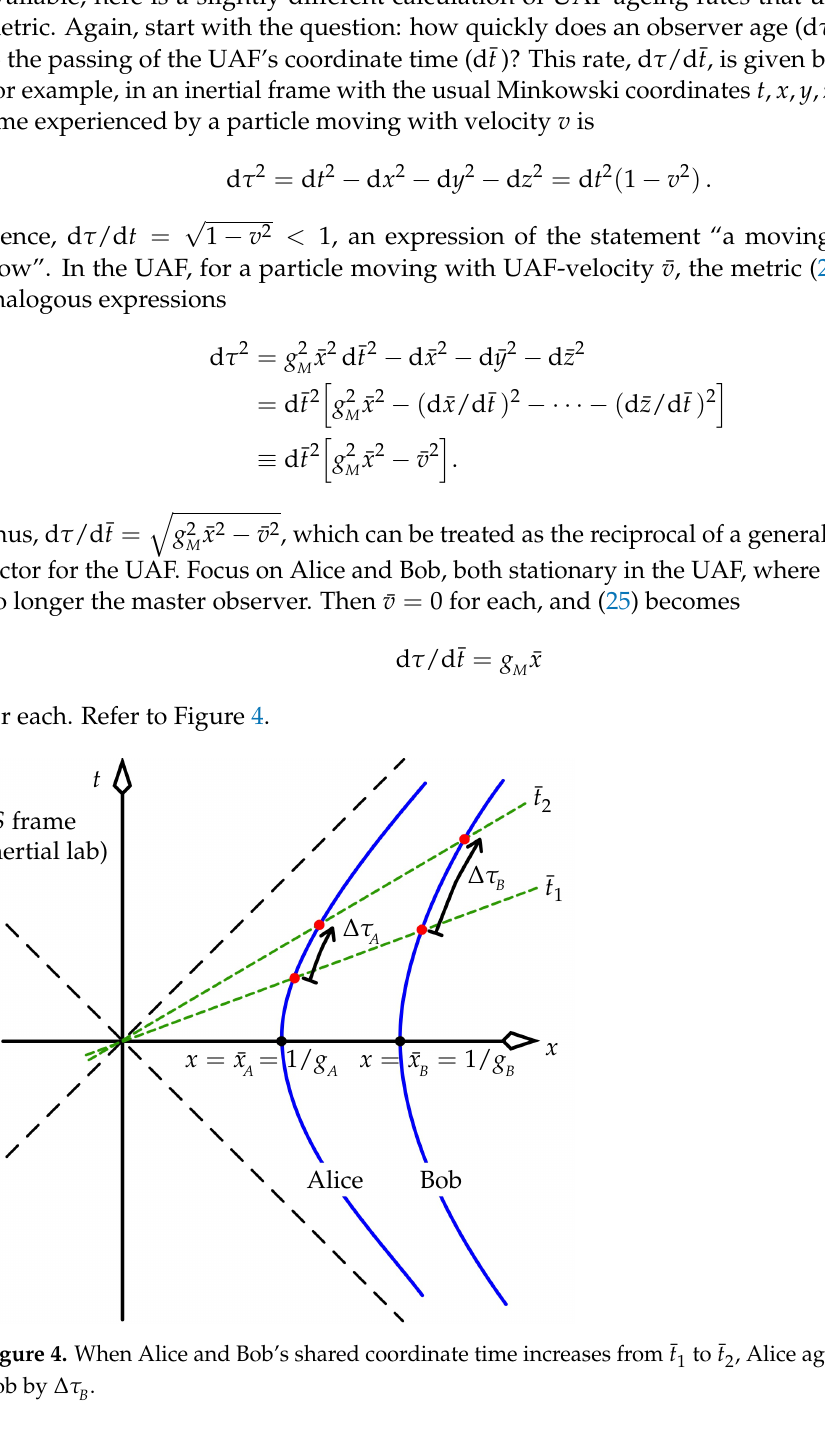
¯ t 1 to 2 , Alice ages by